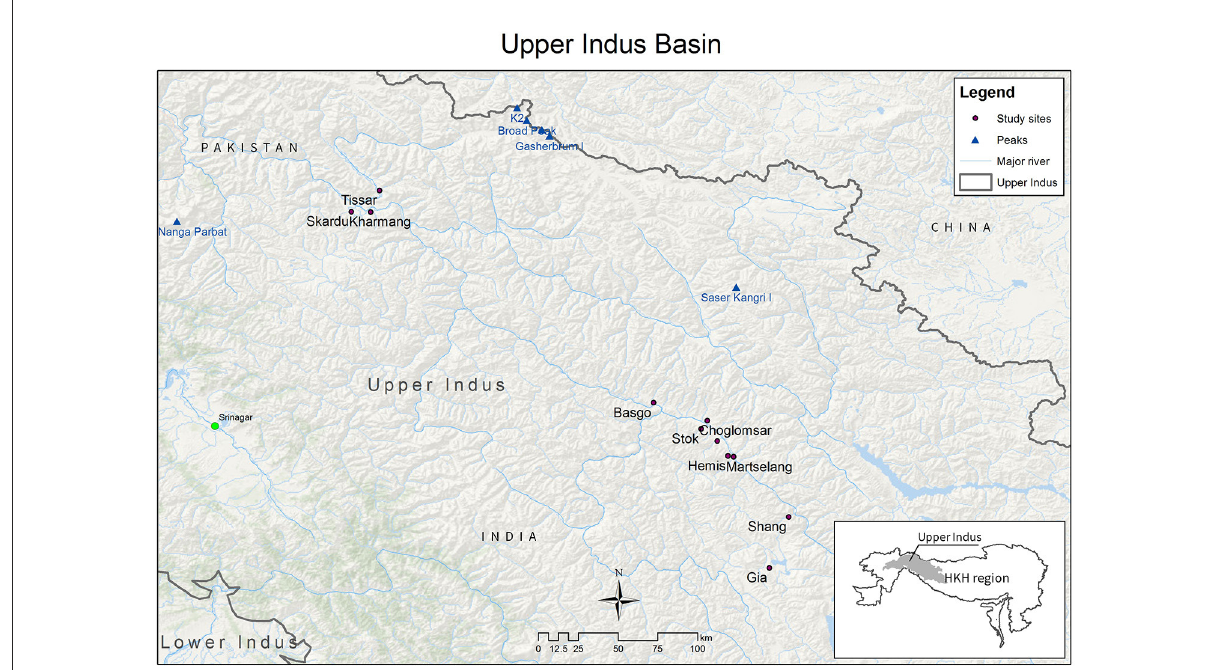
FIGURE1 Map of study villages in Ladakh and Gilgit-Baltistan located within upper Indus